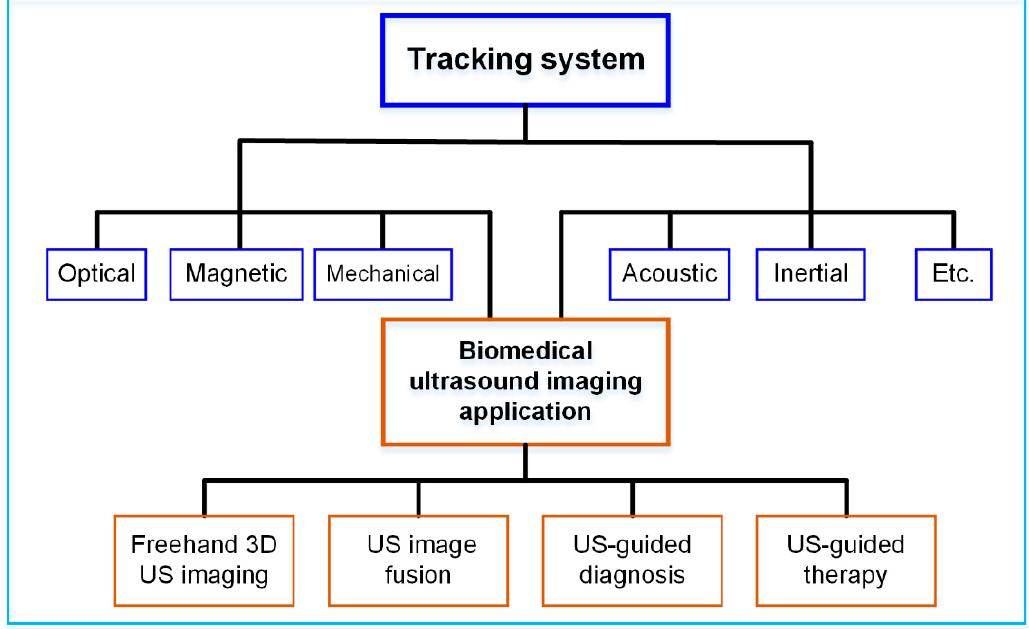
Figure 1. Various tracking systems for biomedical US imaging applications.